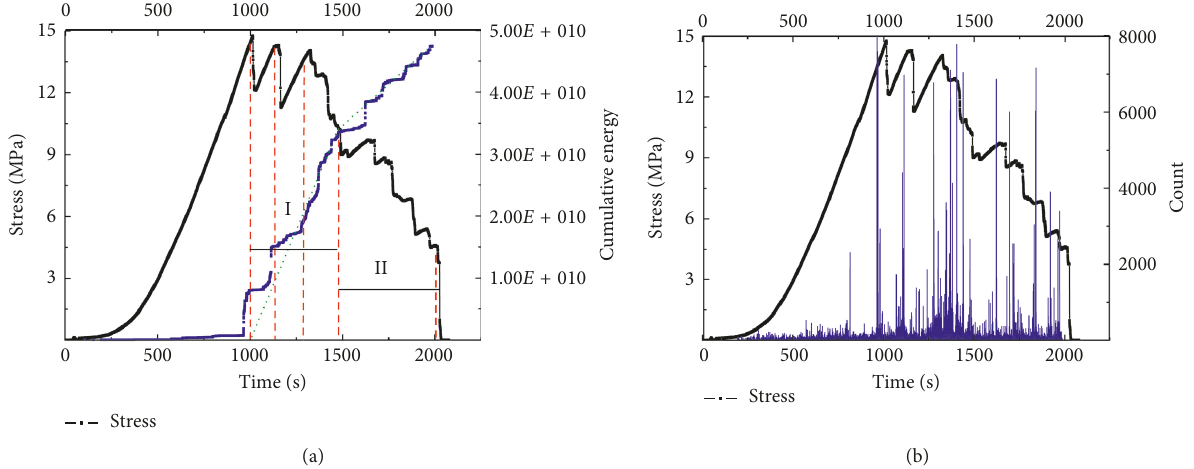
Figure 10: Acoustic emission characteristics of 3 # sample: (a) cumulative energy; (b) count.